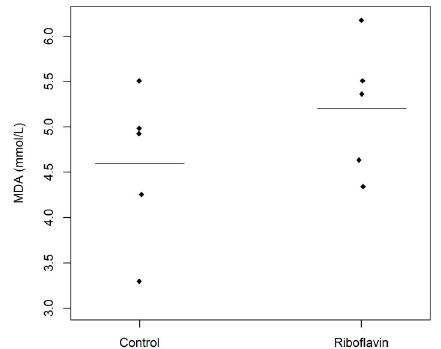
Figure 6. Serum concentrations of malondialdehyde (MDA) (mM) in control and study groups (n=5 animals per group). The horizontal bars represent means. There were no signi fi cant differences between control and study groups.